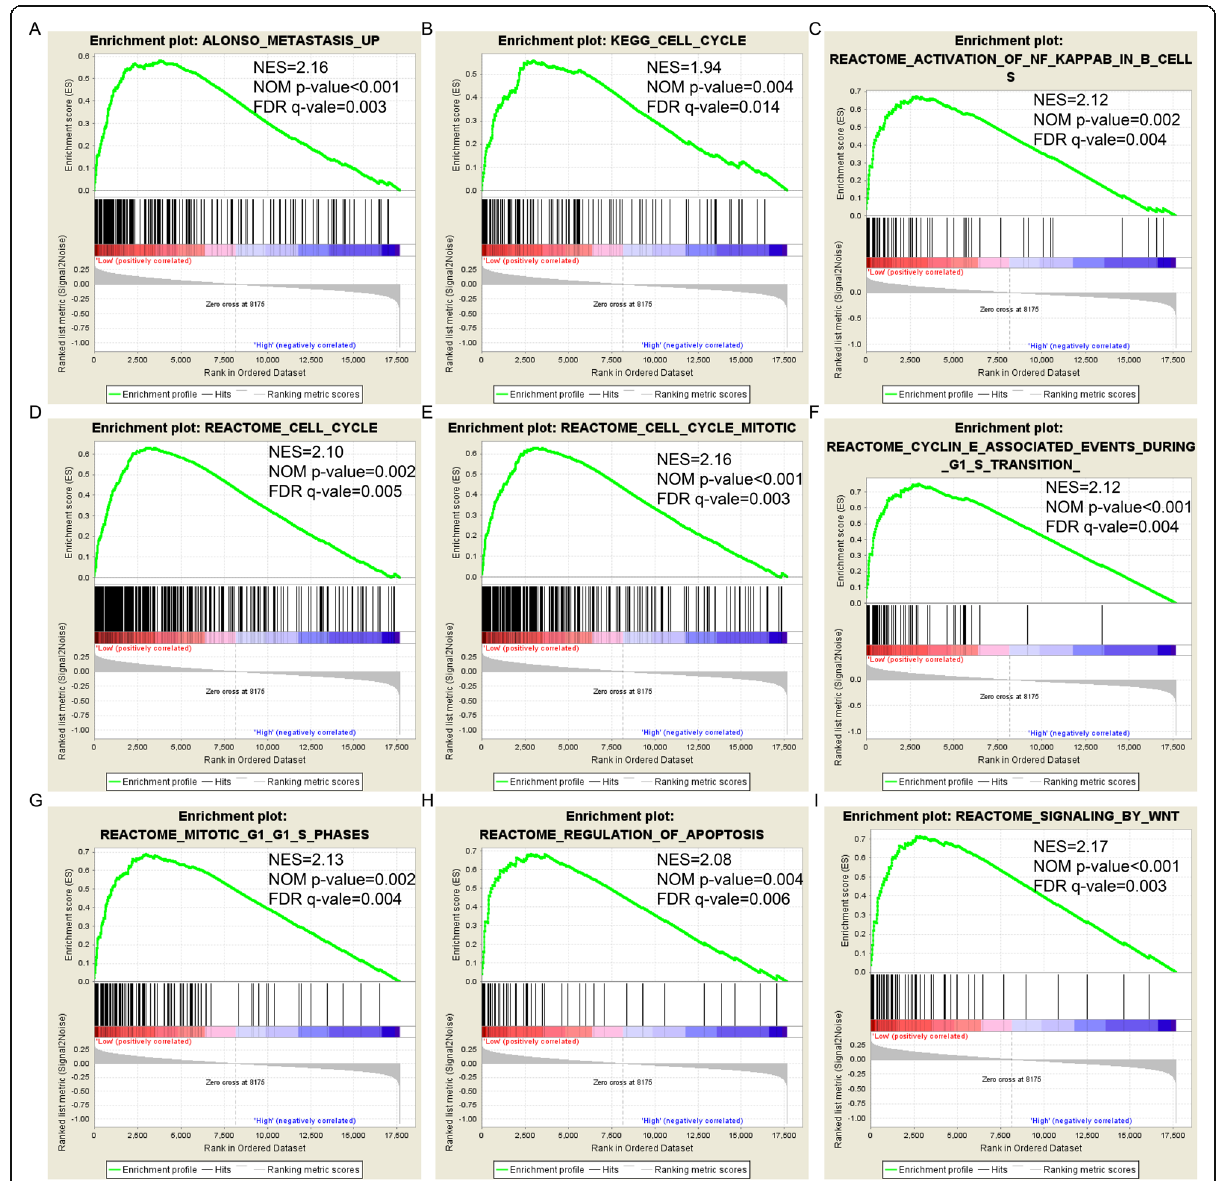
Fig. 8 KEGG enrichment result by GSEA for GSTM2. ( a ) Metastasis up; ( b ) Cell cycle; ( c ) Activation of NF kappa B in B cells; ( d ) Cell cycle; ( e ) Cell cycle mitotic; ( f ) Cyclin E associated events during G1 S transition; ( g ) Mitotic G1/G1/S phases; ( h ) Regulation of apoptosis; ( i ) Signaling by